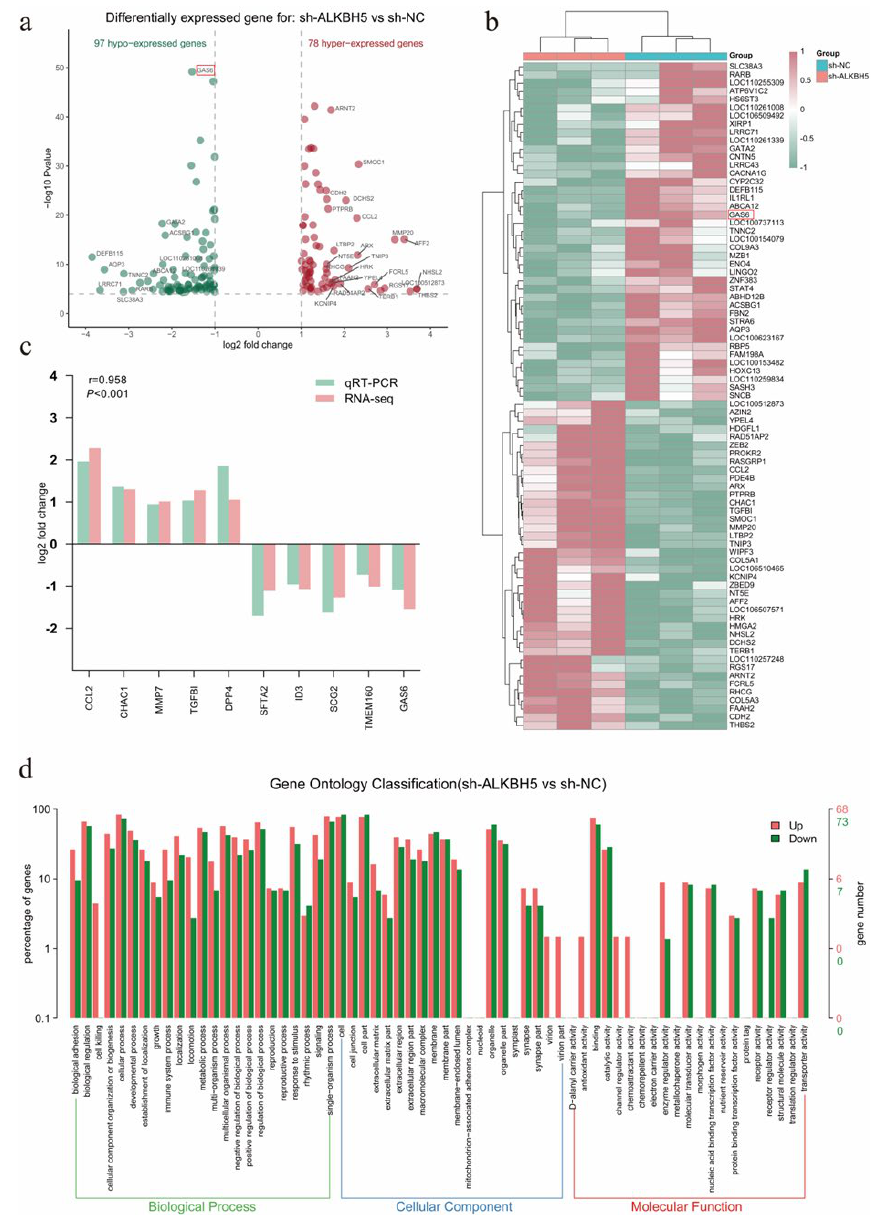
Figure 4. Disruption of ALKBH5 expression by RNAi causes the altered expression of hundreds of genes in 3D4/21 cells. ( a , b ) Volcano plot and heatmap of differentially expressed genes after ALKBH5 gene interference. ( c ) qPCR validation of differentially expressed genes. ( d ) GO enrichment analysis of differentially expressed